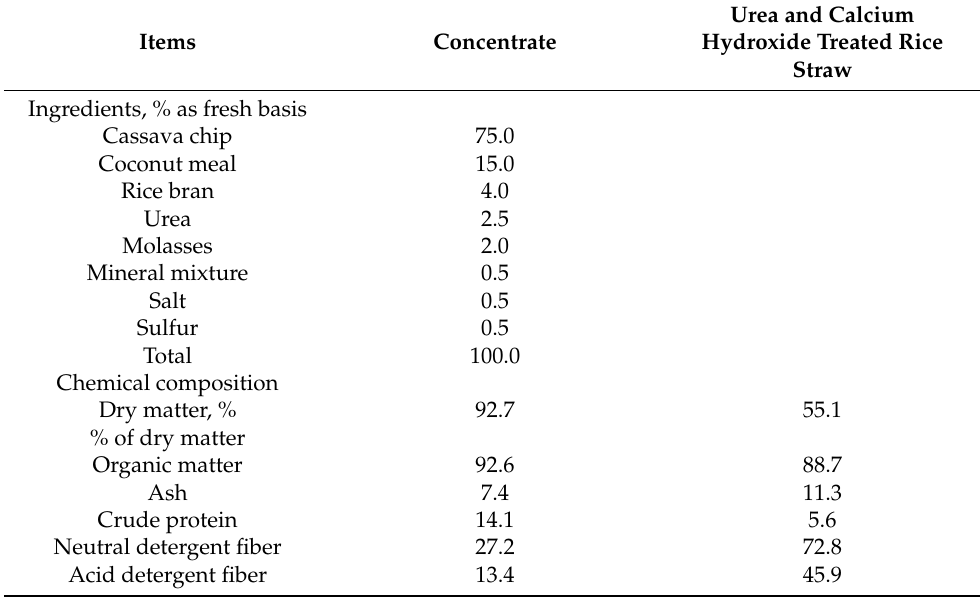
Table 1. Ingredient composition of concentrate and chemical composition of concentrate and treated rice straw offered to steers. Items Concentrate